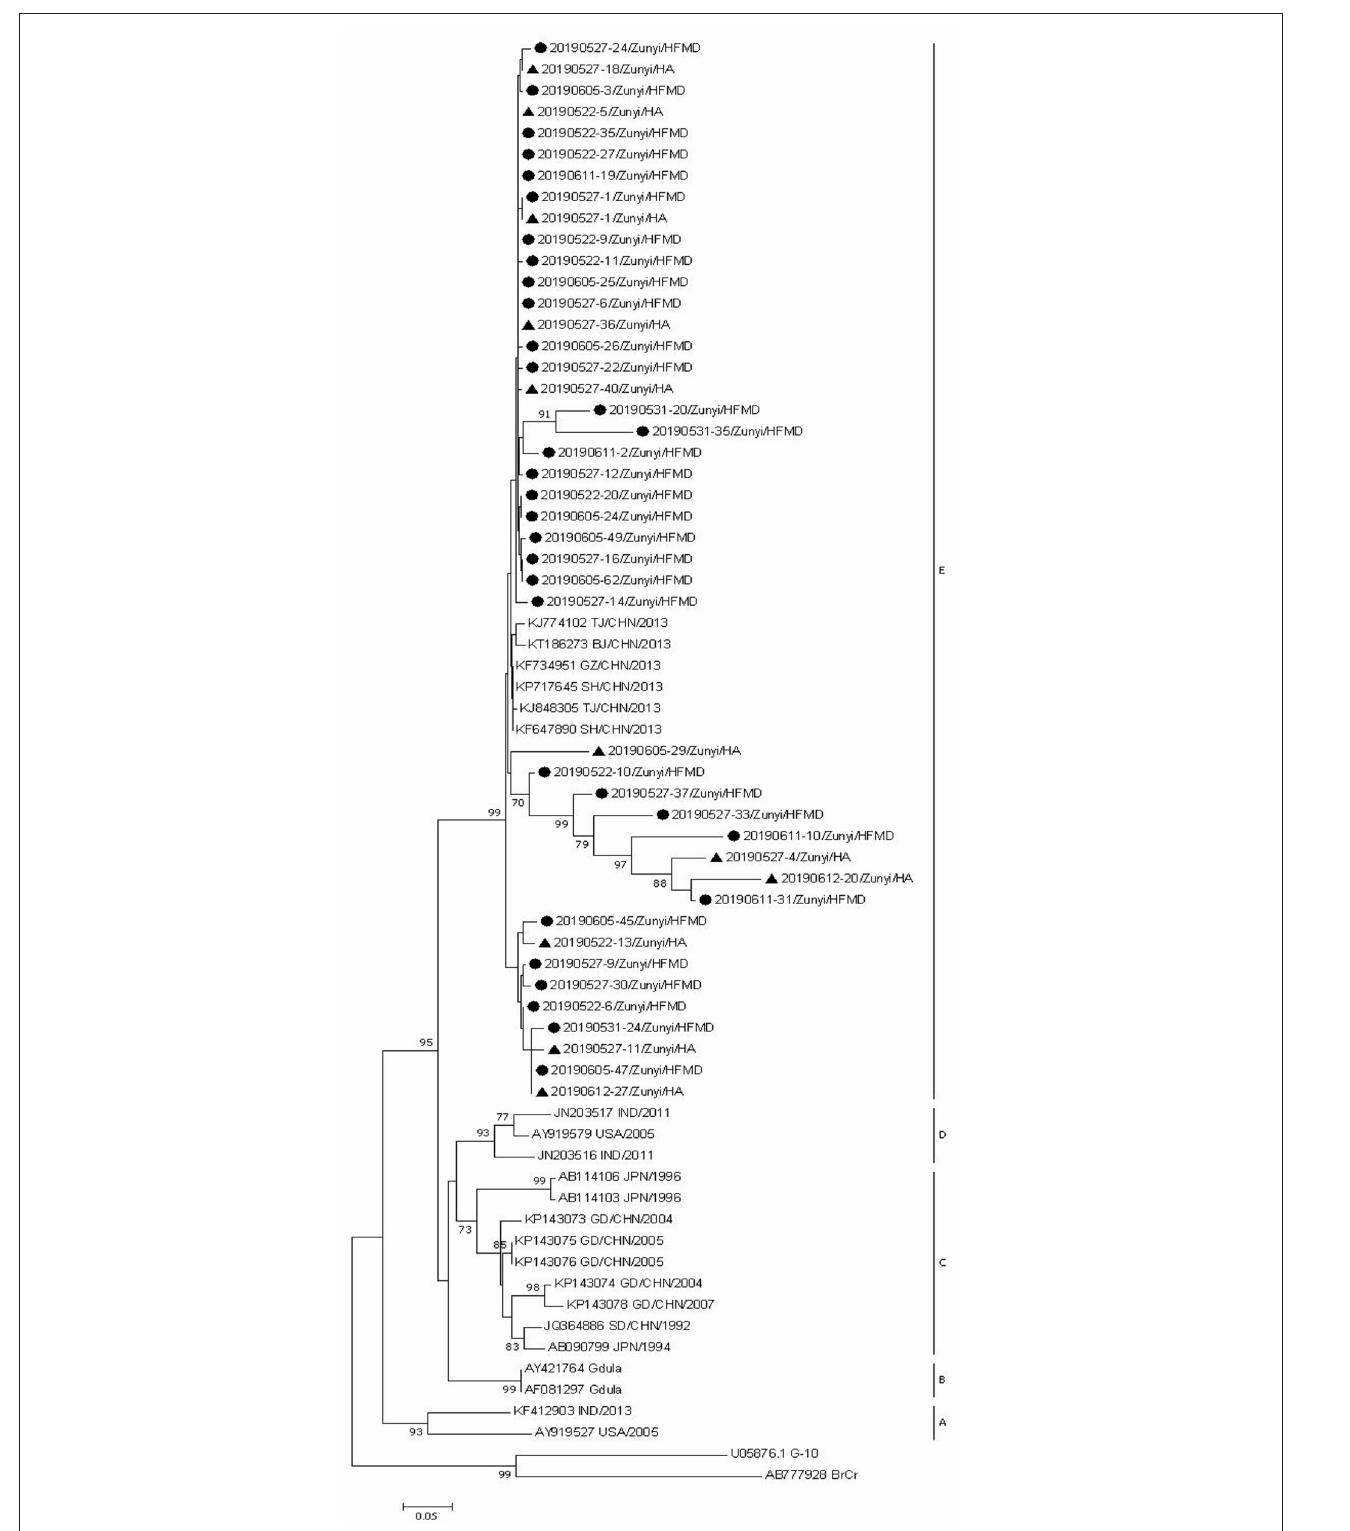
FIGURE 4 | Phylogenetic analysis of CVA6 based on partial VP1 gene sequence. Strains identified from HFMD are marked by circle, and those identified from HA are marked by triangle.